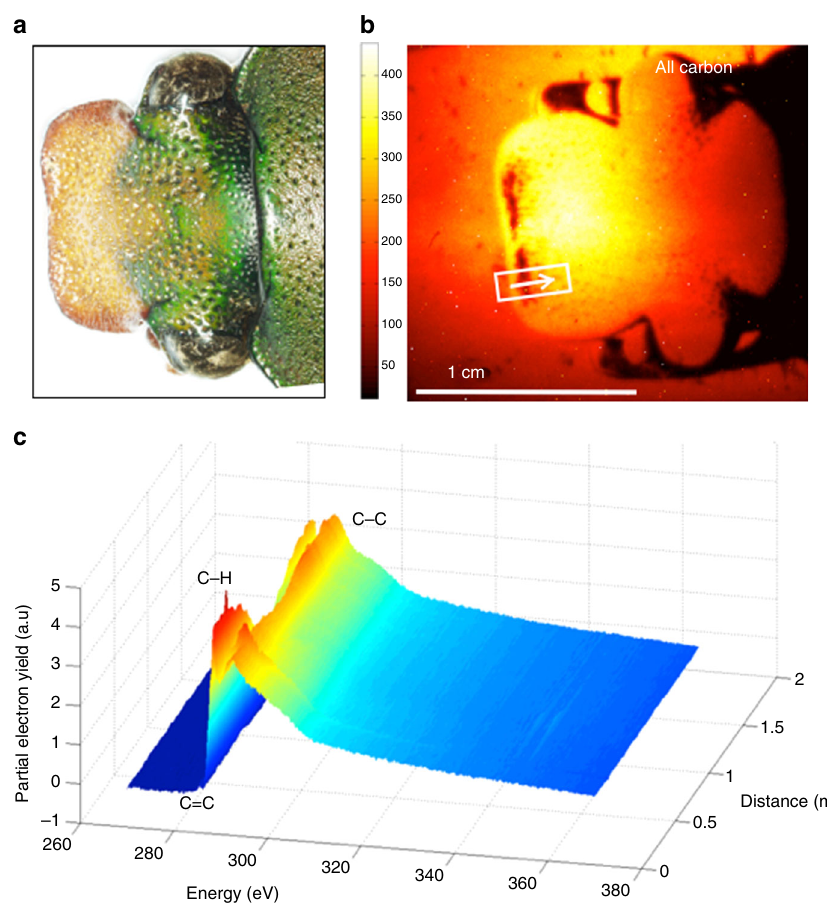
Fig. 3 Imaging of an E. gralli head at the carbon K-edge. a Photograph of the head of fl ower scarab. b NEXAFS image of scarab head. The image is representative of the electron yield across the carbon region 270 – 370 eV. Each pixel contains a full NEXAFS spectrum. c NEXAFS spectra extracted from the image along the line indicated in the